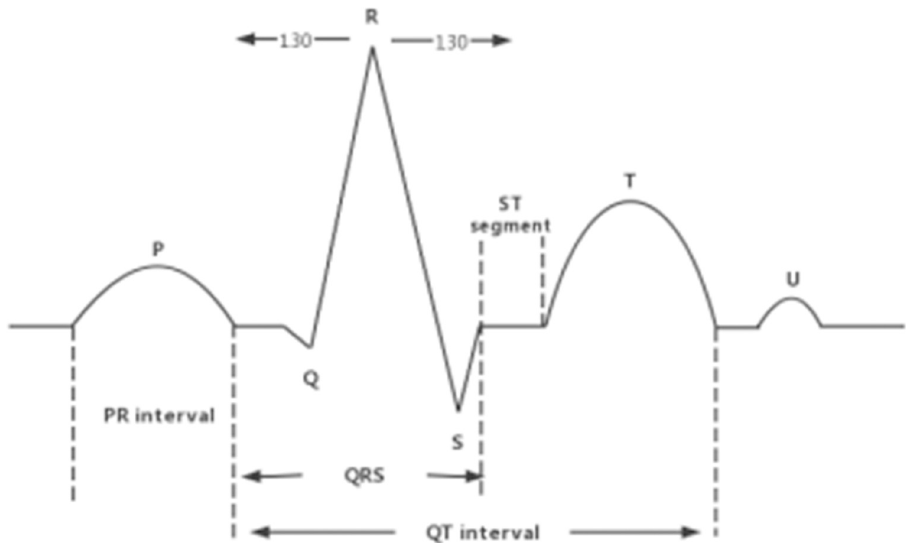
Fig 3. Schematic diagram of heartbeat beat interception centered on the R-peak.